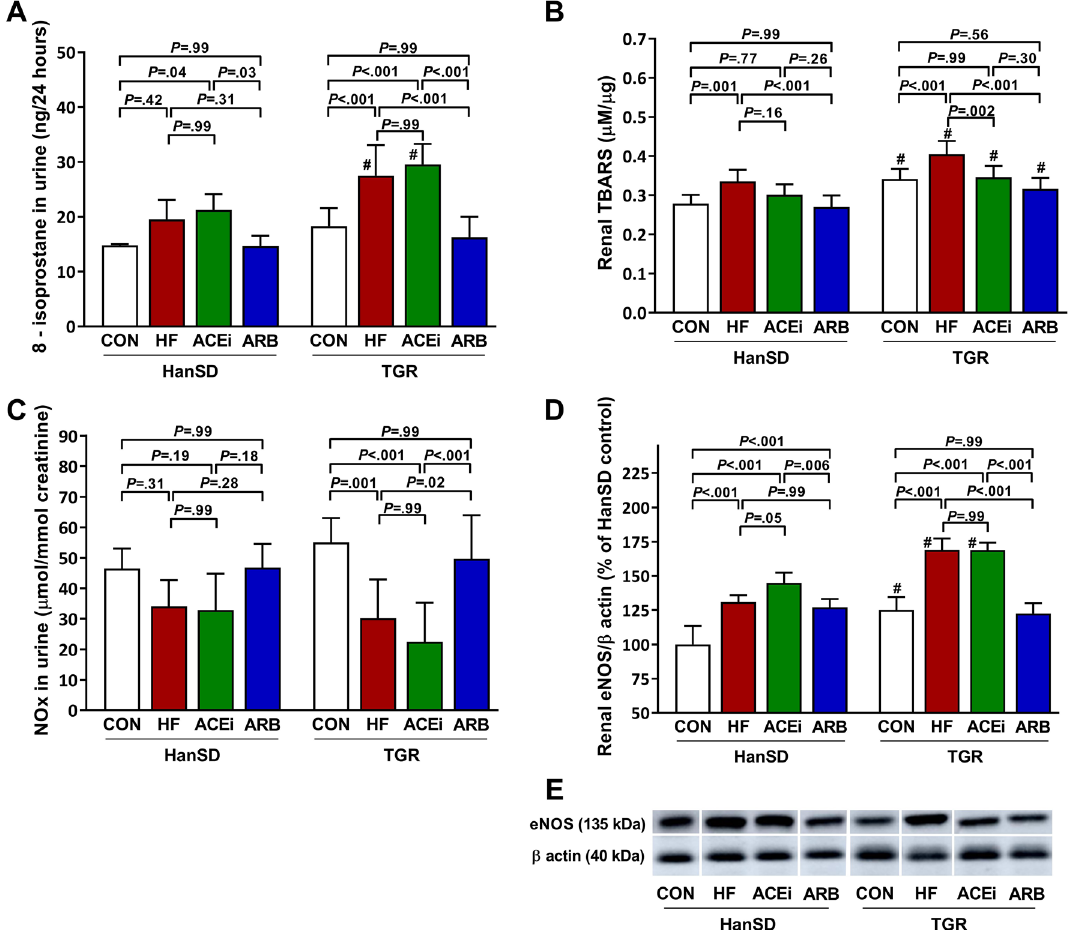
Figure 7. 8-isoprostane urine excretion per 24 h ( A ), renal TBARS ( B ), nitrate and nitrite (NOx) urine excretion ( C ) and renal endothelial nitric oxide synthase (eNOS) to β-actin ratios expressed as a percent change from the average of the control HanSD group ( D ) in control (CON), untreated heart failure (HF), ACE inhibitor-treated (ACEi) and AT 1 receptor blocker-treated (ARB) HanSD and TGR rats 20 weeks after sham or ACF operation (5 weeks in HF TGR rats due to high mortality). Shown in ( E ) are representative western blot images of renal eNOS and β-actin. These images were cropped to improve clarity. All samples were derived from the same experiment and were processed in parallel. Original unprocessed blots can be found in Supplementary Fig. 1. Data presented as mean ± SD (n = 6–9 in each group). # P < 0.05 compared to HanSD